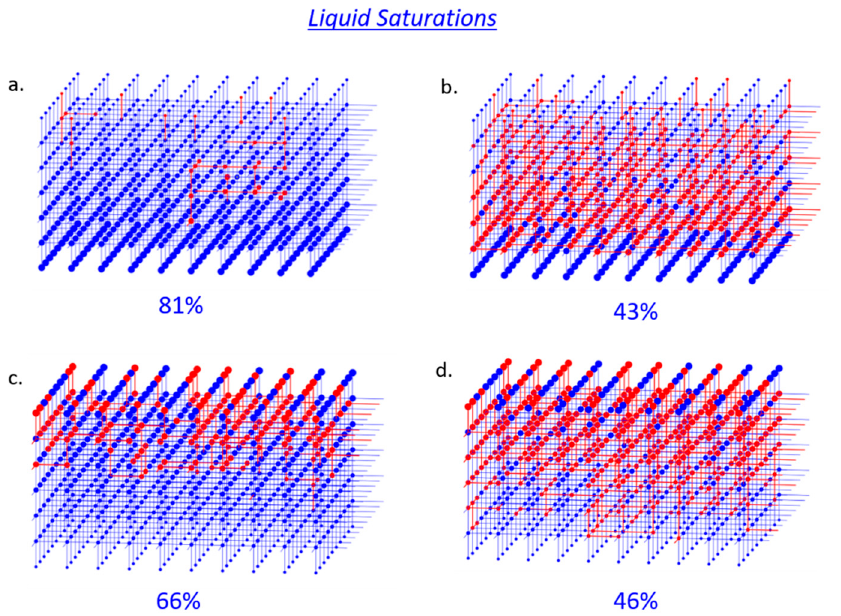
Figure 11. Phase patterns of ( a ) the LTH gradient at the breakthrough point, ( b ) the LTH gradient at the water disconnection point, ( c ) the HTL gradient at the breakthrough point, and ( d ) the HTL gradient at the water disconnection point. Note that the bottom rows (first pore and throat layers) are not invaded due to the applied cluster labeling rules. Due to this, breakthrough denotes the invasion of the first pore in the second pore row. The figures in ( a – d ) are from one pore–throat configuration for each case. The saturation values denote the percentage of saturation with the liquid phase.